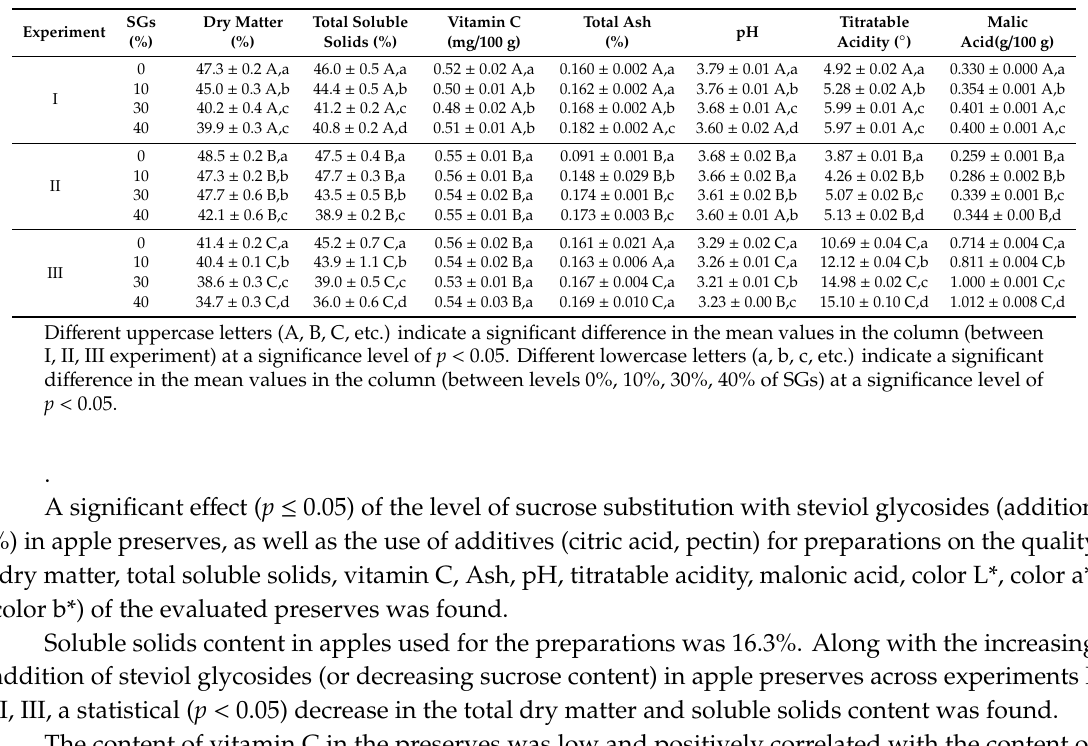
Table 5. Chemical composition of apple preserves ( x ± SD )